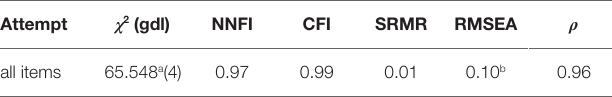
TABLE 8 | Fit indices – “creativity”